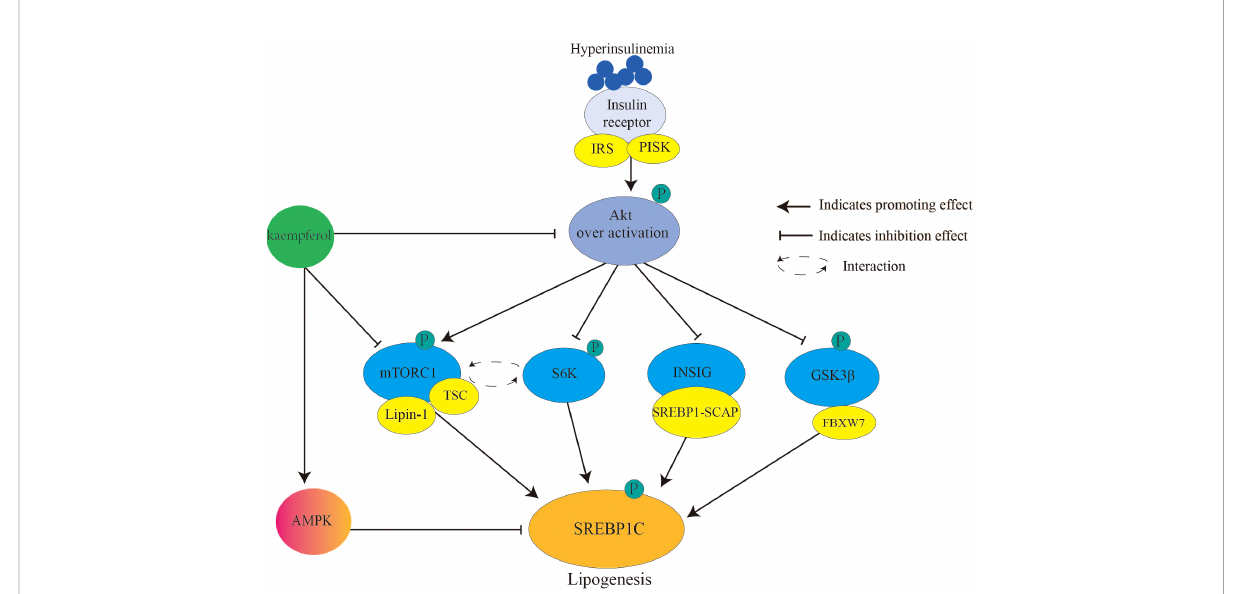
FIGURE 2 Kaempferol reduces SREBPlc to inhibits lipogenesis. Hyperinsulinemia over activates Akt the downstream signaling targets of insulin. Therefore, it causes the activation of AKT/mTORC1/SREBP1C signal and lipogenesis. Kaempferol inhibits the activation of Akt and mTORC1, thereby blocking the activation of the downstream signal SREBP1C. In addition, kaempferol directly activates AMPK to inhibit SREBP1C mediated adipogenesis. IRS, Insulin receptor substrate; PI3K, inosine phosphate 3-kinase; AKT; threonine protein kinase; mTORCl: rapamycin complex 1; S6K, ribosomal protein S6 kinase; INSIG: insulin induced target gene protein; GSK3 b , Glycogen synthesis kinase 3 b ; TSC, tuberous sclerosis; SREBP1, sterol regulatory element binding proteinsl; SCAP, SREBP cleavage-activating protein; FBXW7, F-box and WD repeat domain containing 7; AMPK, AMP-activated protein